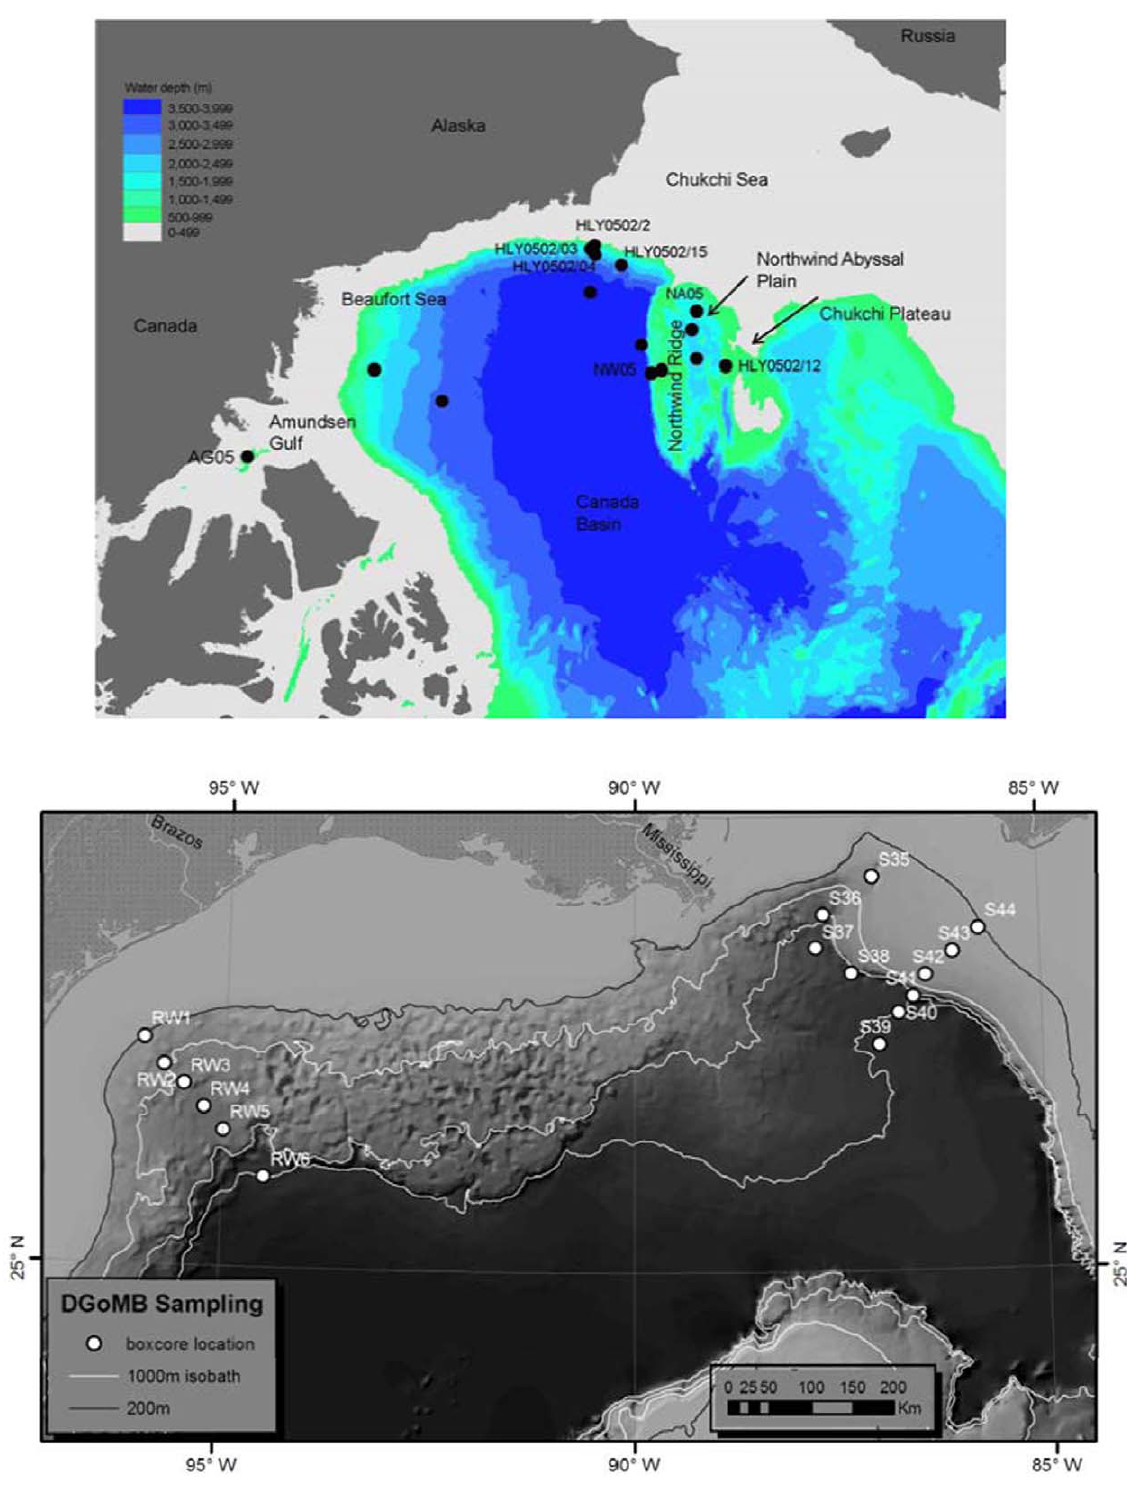
Figure 1. Sampling locations. A. Canada Basin. B. Gulf of Mexico (from Wei et al. [34] revised by Chih-Lin Wei).